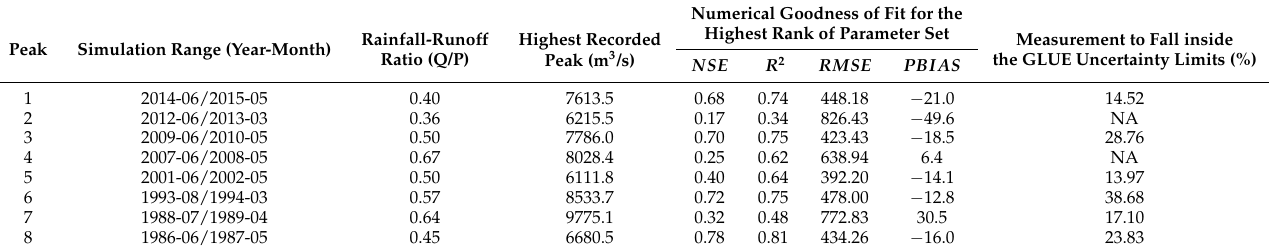
Table 2. The segmented simulation result of peaks over 32 years.